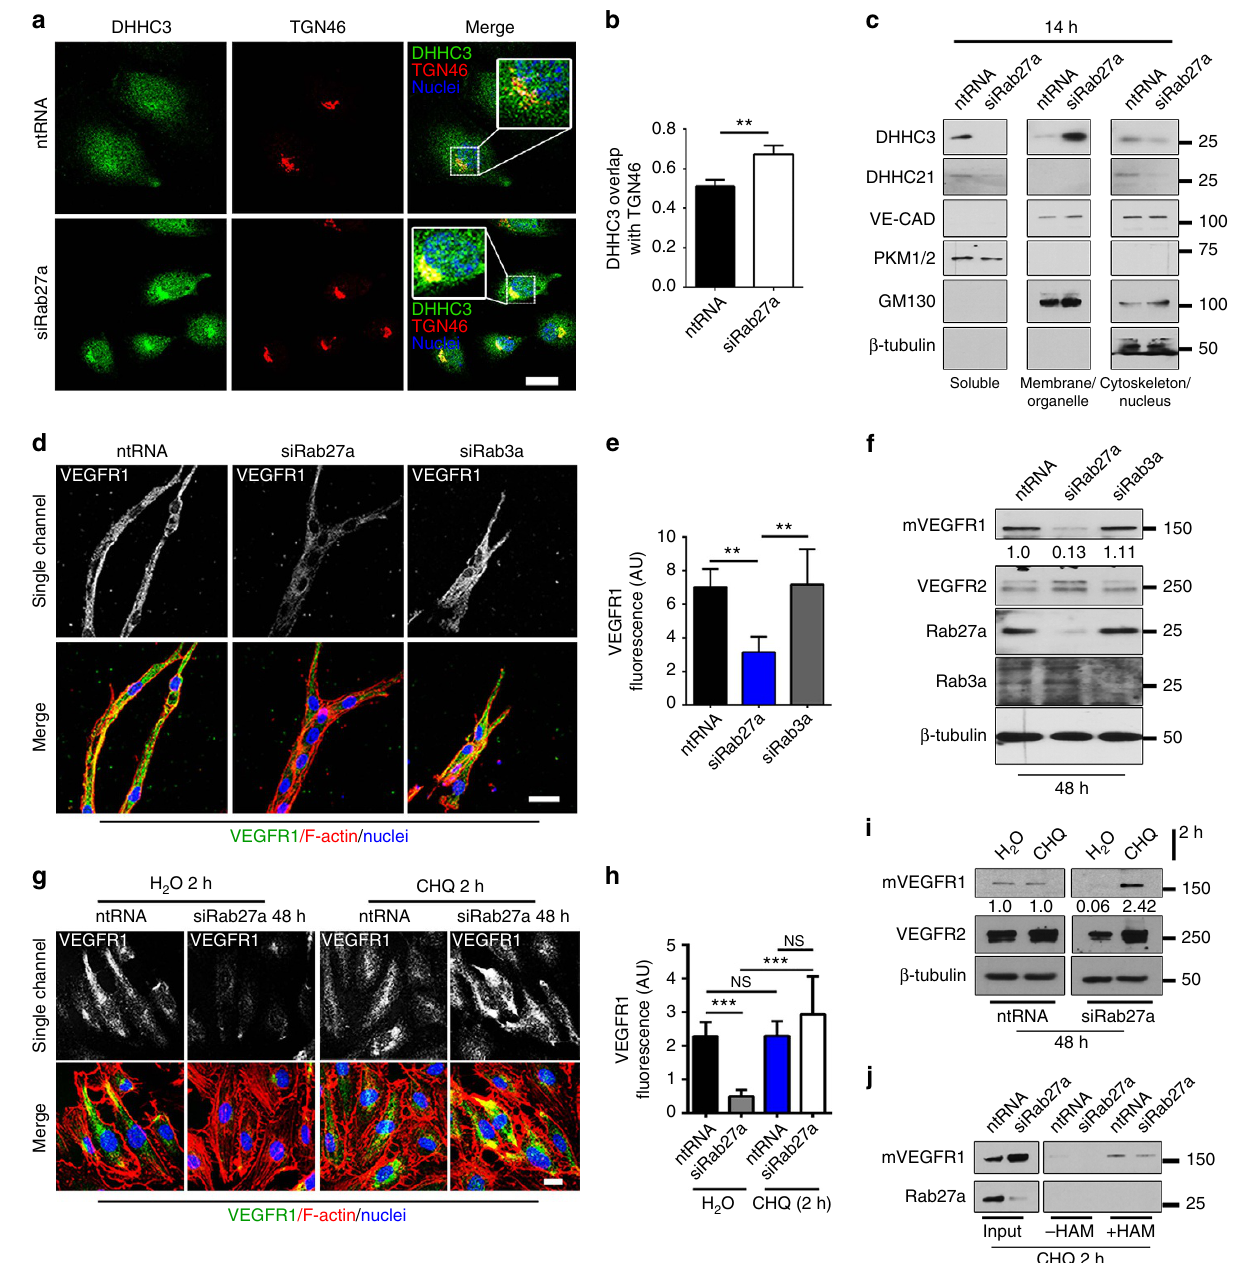
Figure 5 | Rab27a regulates DHHC3 localization and palmitoylation of VEGFR1. ( a , b ) DHHC3 and TGN46 (Golgi) immunofluorescence ( a ) and Mander’s Correlation Coefficient quantification ( b ) of overlap in HUVEC with indicated treatments; three replicates, scale bar: 20 m m. ( c ) Subcellular fractionation and immunoblot of HUVEC with indicated treatments. Pyruvate kinase1/2 (PKM1/2), soluble marker; vascular-endothelial cadherin (VE-CAD), membrane and cytoskeletal marker; cis-Golgi Marker 130 (GM130), membrane marker; two replicates. ( d , e ) ( d ) VEGFR1 immunofluorescence of d4 HUVEC angiogenic sprouts with indicated siRNAs, scale bar: 25 m m. ( e ) Quantification of fluorescence via integrated density. (No. of sprouts: ntRNA, n ¼ 7; siRab27a, n ¼ 9; siRab3a, n ¼ 5); three replicates. ( f ) Immunoblot of HUVEC with indicated treatments. Values are relative mVEGFR1 levels. Doublet in VEGFR2 lane is likely due to glycosylation; four replicates. ( g , h ) ( g ) VEGFR1 immunofluorescence of HUVEC with indicated treatments, scale bar: 15 m m. ( h ) Quantification of fluorescence via integrated density. (No. of cells: ntRNA, H 2 O, n ¼ 28; CHQ, n ¼ 22; siRab27a, H 2 O, n ¼ 13; CHQ, n ¼ 15); two replicates. ( i ) Immunoblot of HUVEC with indicated treatments. Values are relative mVEGFR1 levels; 3 replicates. ( j ) Acyl-RAC and immunoblot of HUVEC with indicated siRNAs; three replicates. Statistics: Shown are means þ 95% CI. One-way ANOVA with pairwise comparison and post-hoc Tukey’s range test ( e , h ); student’s t -test ( b ). ** P r 0.01; *** P r 0.001; NS, not